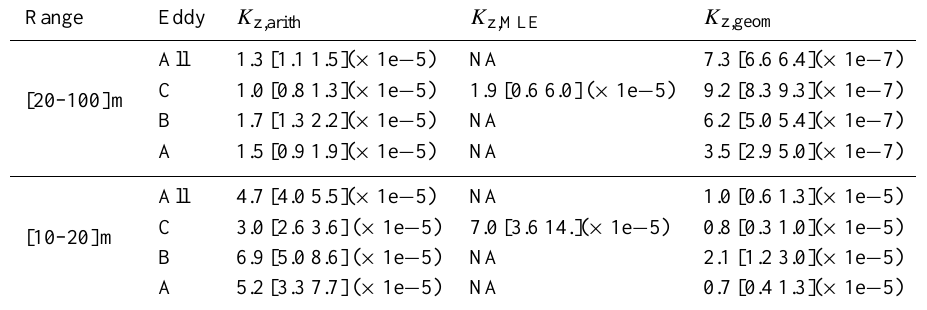
Table 2. Mean K z estimations ( m 2 s − 1 ) from various methods, arithmetic mean, MLE of the log-normal distribution mean, geometric